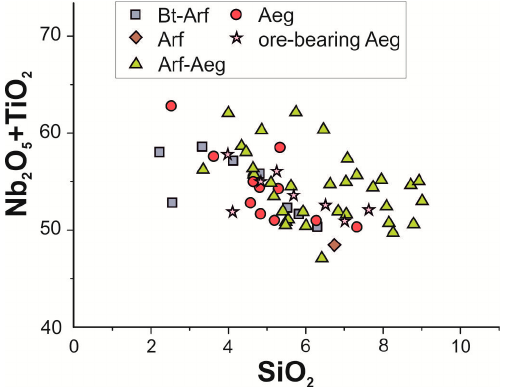
Figure 6. SiO 2 vs Nb 2 O 5 + TiO 2 diagram (wt.%) for secondary-II pyrochlore from the Katugin